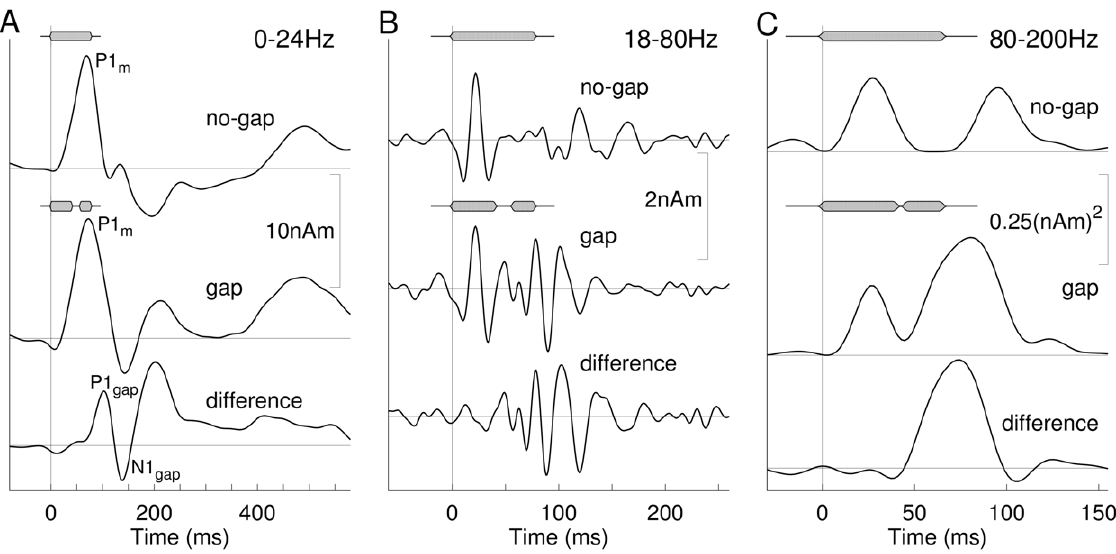
Figure 3. Comparison of responses to no-gap and gap stimuli using difference waveforms. As an example, the responses to the stimulus with long leading marker and long gap (40-16-20 ms) are shown as grand average for the young group. A : Waveforms of the 0–24 Hz low-pass filtered responses show similar P1 m waves for the gap and no-gap condition. In the difference waveform (lower trace), a clear P1 m -N1 m -P2 m like pattern appears with delayed latency compared to the onset response. B : Waveforms of the 18–80 Hz band-pass filtered responses. The transient onset response is almost identical for the gap and no-gap response and is cancelled out in the difference waveform, which shows a more complex pattern of oscillation than the onset response. C : Signal power of the 80–200 Hz filtered high-gamma band data. Two bursts of high-gamma activity occur for the gap and no-gap stimulus, respectively. The second gamma burst for the gap stimulus is largest and appears earlier than the second burst for the no-gap stimulus. The difference in signal power shows predominantly a single burst of high-gamma activity.